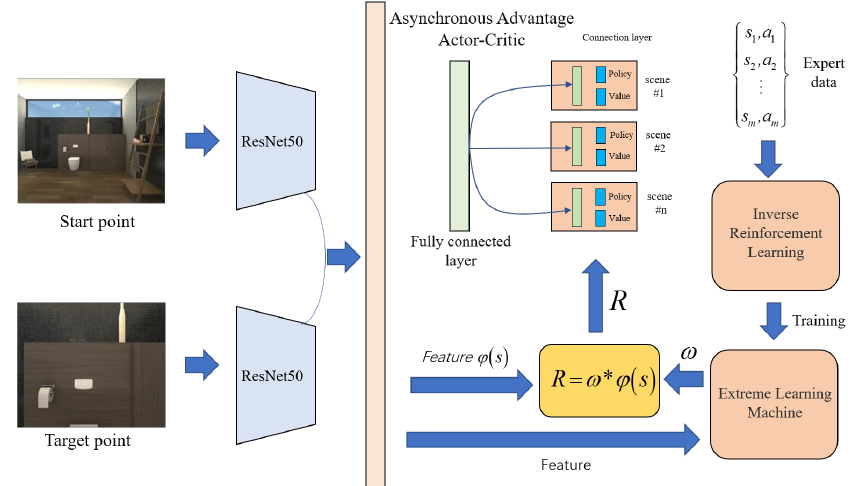
Figure 2. Framework diagram of our algorithm (RELM-IRL). First, resnet-50 is used to extract the features of the observed image. Meanwhile, the ELM is trained with the features and reward function found by IRL. Then, we regularize the ELM and finally input the obtained reward function to obtain the navigation